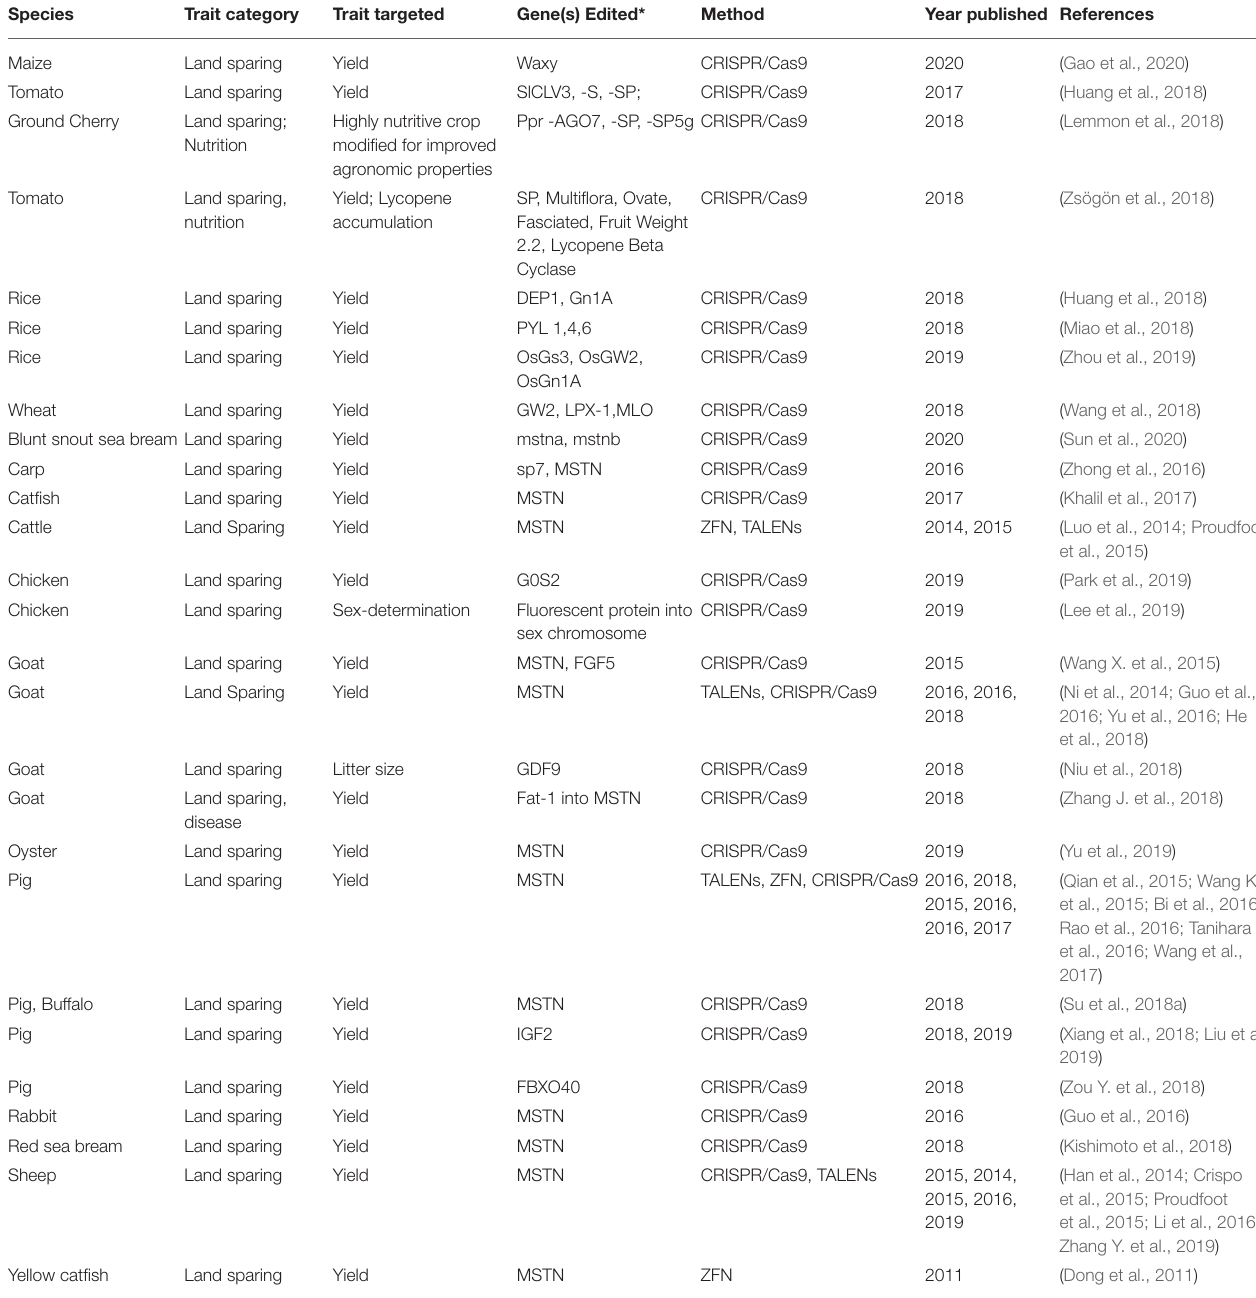
TABLE 3 | Summary of gene-editing applications for land